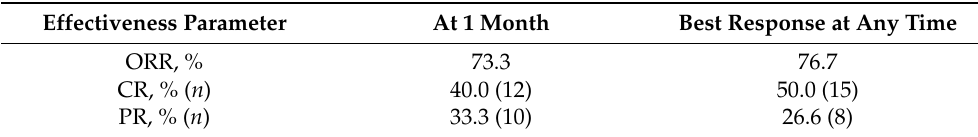
Table 2. Effectiveness of CAR T-cell therapy in 30 treated patients.